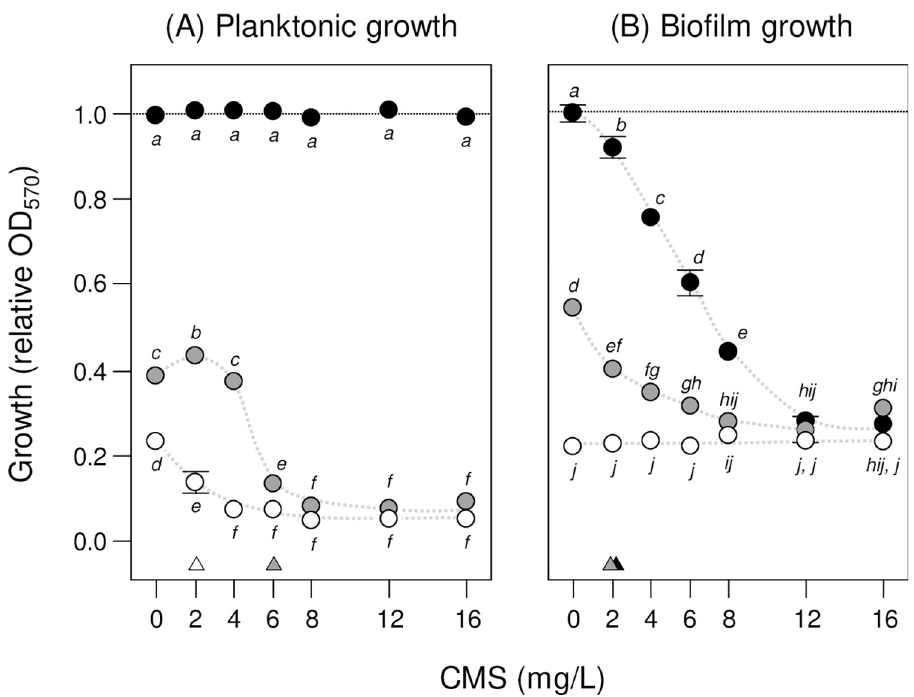
Fig 3. AZM and CMS synergistically inhibit K . pneumonia planktonic and biofilm growth. The effect of azithromycin (AZM) and colistin methanesulfonate (CMS) on K . pneumonia ATCC 10031 (A) planktonic and (B) biofilm growth was investigated by optical density (OD 570 ) measurements after 16 h and 24 h incubation, respectively. Data are shown as mean relative OD 570 ± SE ( n = 3), with no-AZM (control) treatments indicated by dark circles, 3 mg/L AZM by grey circles and 9 mg/L AZM by white circles (trends are suggested by dashed curves). Means not connected by the same letters are significantly different (LSMeans Differences Tukey HSD, alpha = 0.05 for planktonic and biofilm growth mixed-effects models of relative OD 570 ). Small triangles indicate planktonic and biofilm minimum inhibitory concentrations (MIC) where relative OD 570 was first significantly reduced by CMS for each AZM treatment.